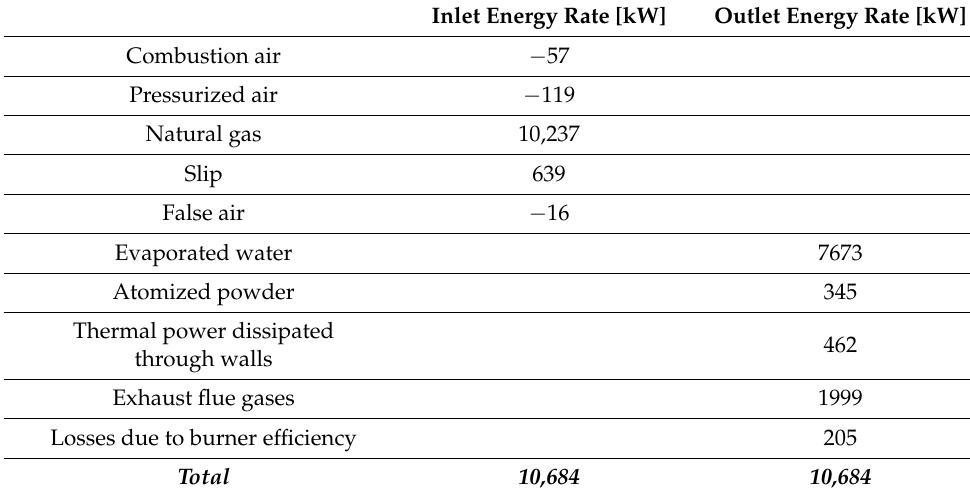
Table 3. Main results of ATM 110 thermodynamic modelling for gaseous streams. Exhaust Flue Gases Hot Flue Gases (Leaving the Atomizing (Entering the Atomizing Tower, Section 7 Tower, Section 5 in Figure 3) in Figure 3) [kg/s] 17.63 22.26 [m 3 /s] 38.46 Flow rate Molar mass temperature